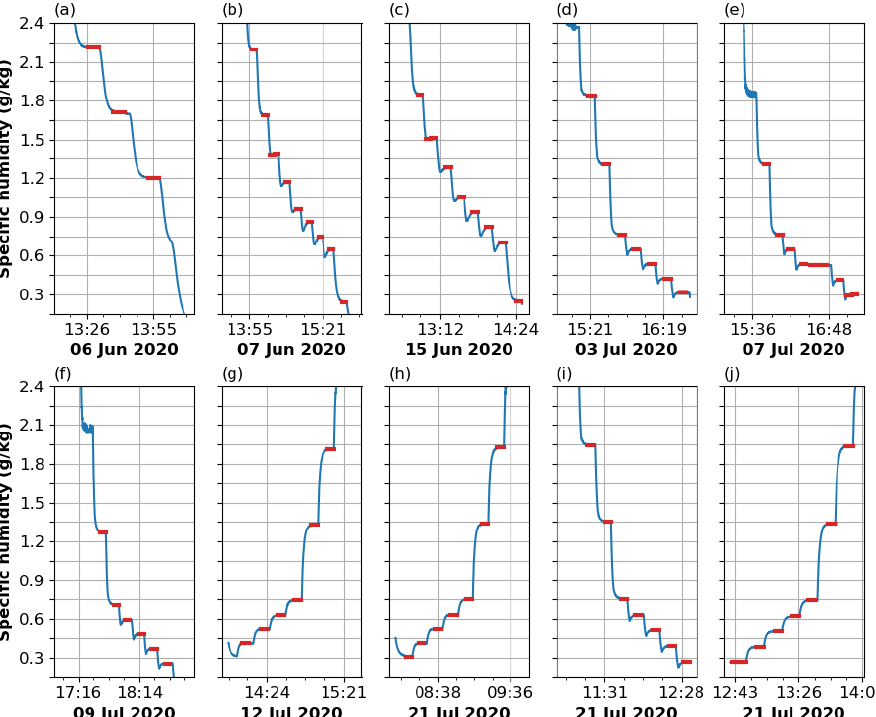
Figure B1. Humidity step sequences from 10 (a–j) distinct usage events from laboratory characterization of the analyzer during the period of June to July 2020. Blue line depicts volumetric mixing ratio, with red highlights showing 5min periods with a standard deviation less